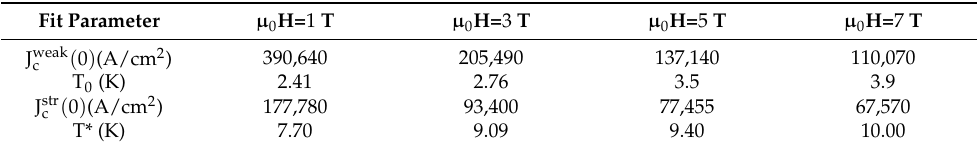
Figure 4. Temperature dependence of J c at µ 0 H = 1 T ( a ) and µ 0 H = 3 T ( b ) fitted with weak pinning equation (blue dotted line) and strong pinning equation (red solid line); temperature dependence of J c at µ 0 H = 5 T ( c ) and µ 0 H = 7 T ( d ) fitted with the weak pinning equation (blue dotted line), the strong pinning equation (red solid line) and the combination of weak and strong pinning equations (solid green line). Table 1. Parameters values of the fit procedure performed in Figure